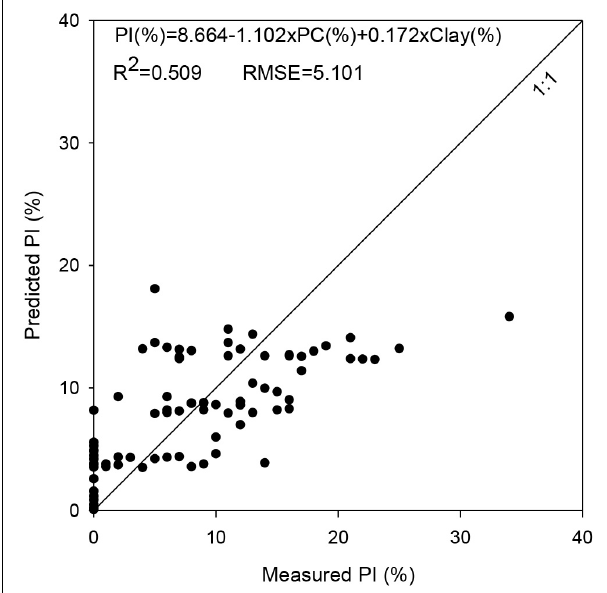
FIGURE 5 | Comparison of measured PI and predicted PI of the cement treated soils.